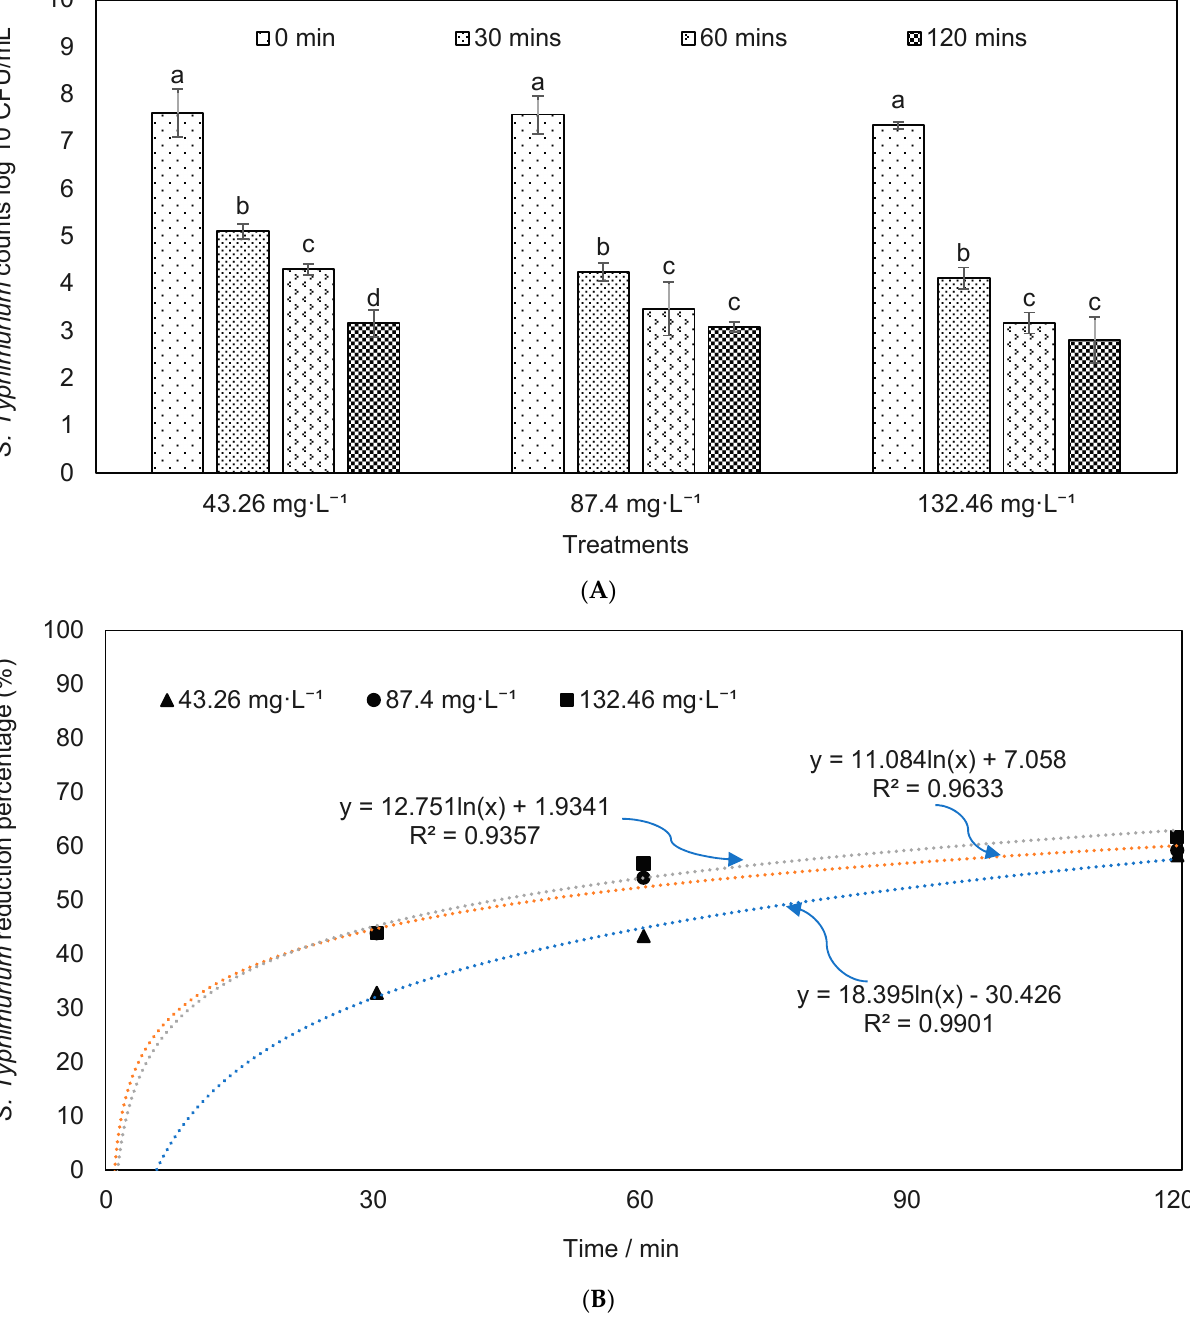
Figure 5. S. typhimurium ( A ) counts and ( B ) reduction percentages in the autoclaved dairy manure inoculated with S. typhimurium under different ozone concentrations and durations (means denoted by a different letter indicate significant differences between treatments ( p <